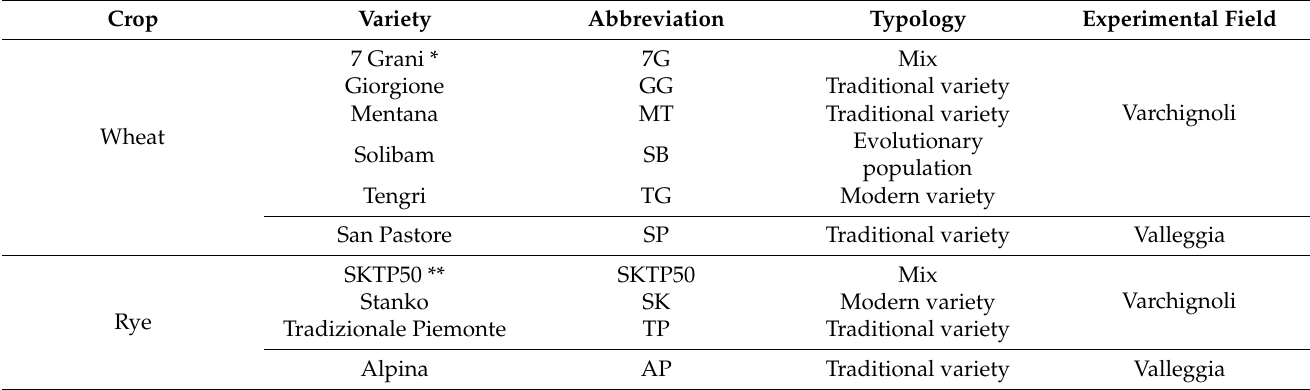
Table 1. Varieties of wheat and rye used. Experiments were carried out in two locations: Varchignoli and